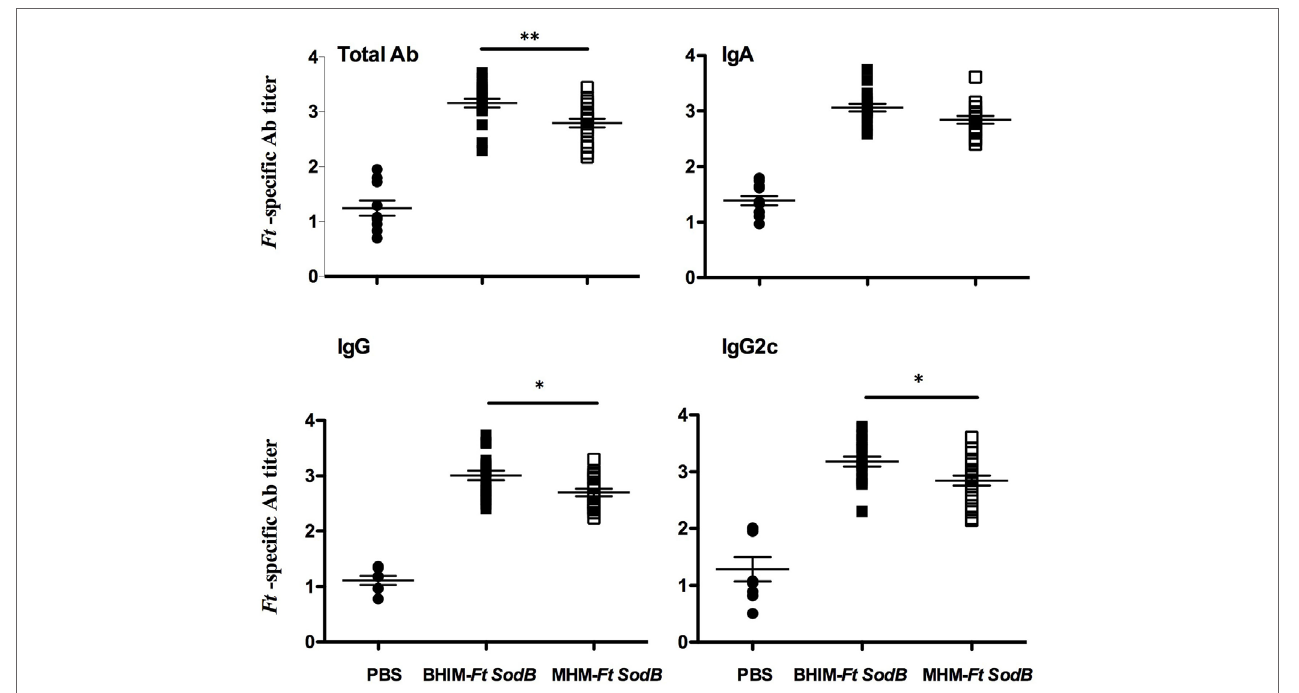
FigUre 6 | Immunization with brain-heart infusion medium (BHIM)- Francisella tularensis ( Ft ) sodB results in elevated Ab responses. C57BL/6 female mice were immunized with BHIM or MHM- Ft sodB as described in Figure 4 . Sera obtained 3 weeks post-immunization were analyzed by enzyme linked immunosorbent assay (ELISA) for Ft -specific total Ab, IgA, IgG, and IgG2c Ab titers. Values represent mean ± SE of two combined experiments ( n = 20 mice per group). Error bars represent SEM. * p < 0.05 and ** p <